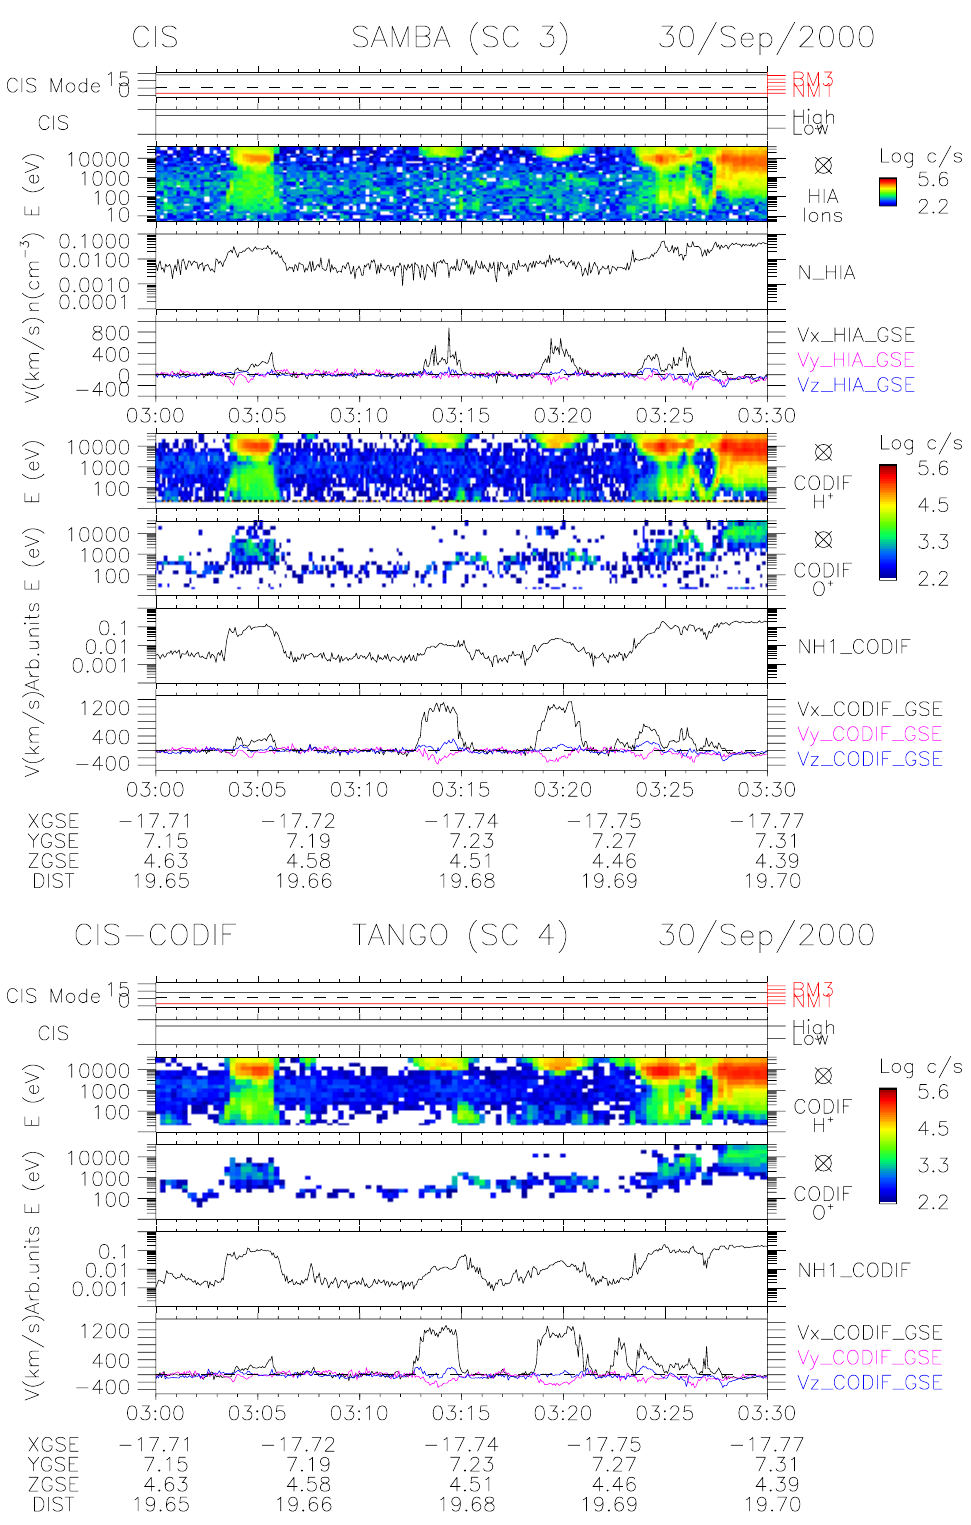
Fig. 22. Simultaneous measurements on 30 September 2000 between 03:00 and 03:30UT with spacecraft 3 (CODIF and HIA) and space- craft 4 (CODIF). From top to bottom, the upper panel shows for spacecraft 3, the CIS telemetry modes, the HIA energy-time spectrogram integrated over 4 5 , the HIA ion density, onboard HIA GSE velocity components, H + and O + CODIF energy-time spectrogram integrated over 4 5 , H + CODIF density and onboard GSE velocity components measured by CODIF. The lower panel shows the identical CODIF measurements for spacecraft